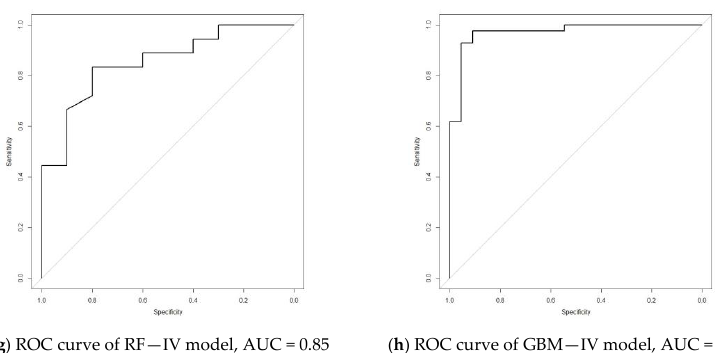
( g ) ROC curve of RF— Ⅳ model, AUC = 0.85 ( h ) ROC curve of GBM— Ⅳ model, AUC = 0.97 Figure 1. ROC curves of each model. The horizontal axis represents specificity (from 1 to 0), and the vertical axis represents sensitivity (from 0 to 1).